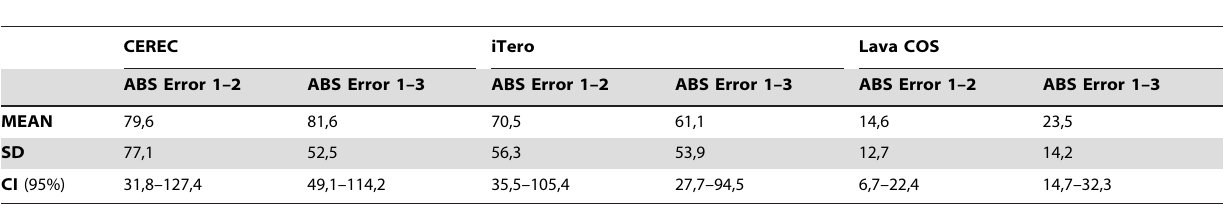
Table 1. Absolute errors in the distance between the cylinders in micrometers.